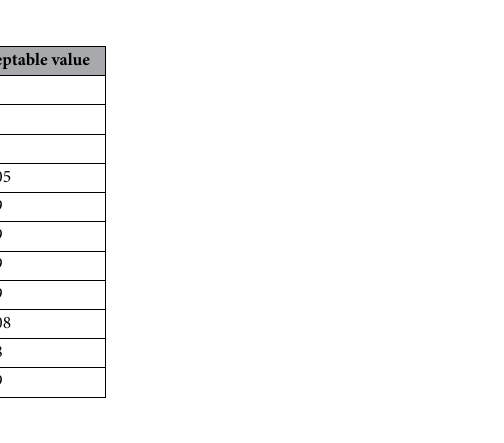
Table 6. The model fit